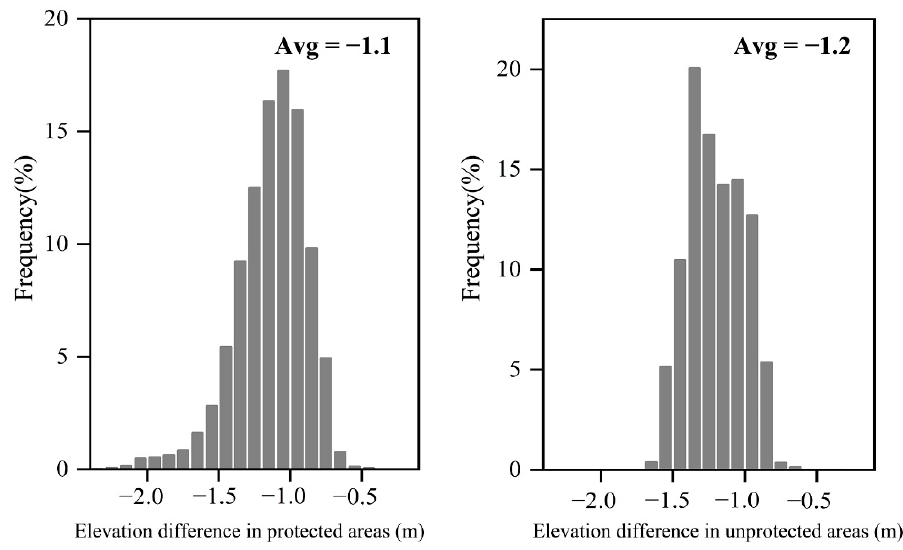
Figure 8. Histogram illustrating the elevation changes that occurred in the protected ( left ) and un ‐ protected ( right ) regions of DG17. The area has been outlined using the red block in Figure